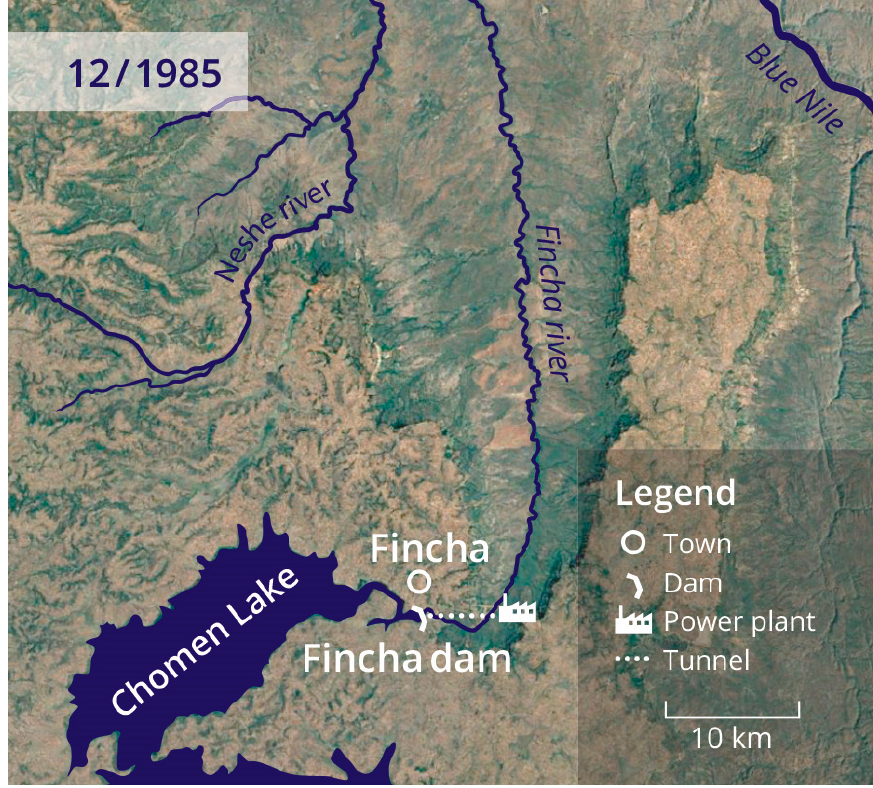
Figure 3. The study site after completion of Fincha dam (1973) in December 1985.